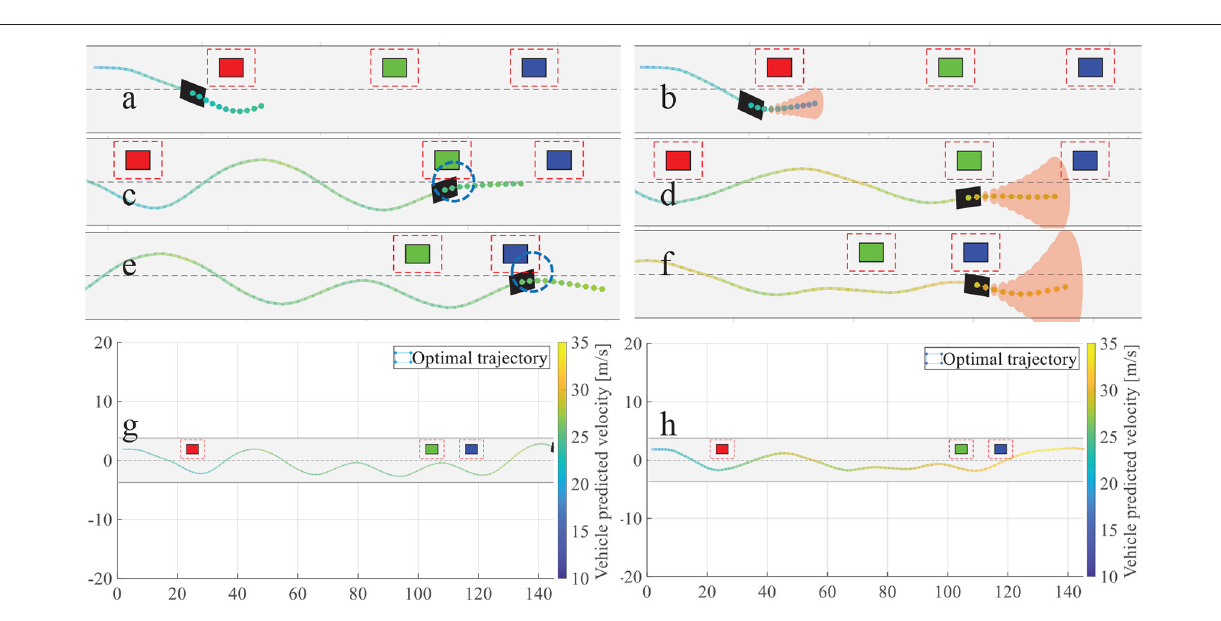
to reduce the computation need for optimization.